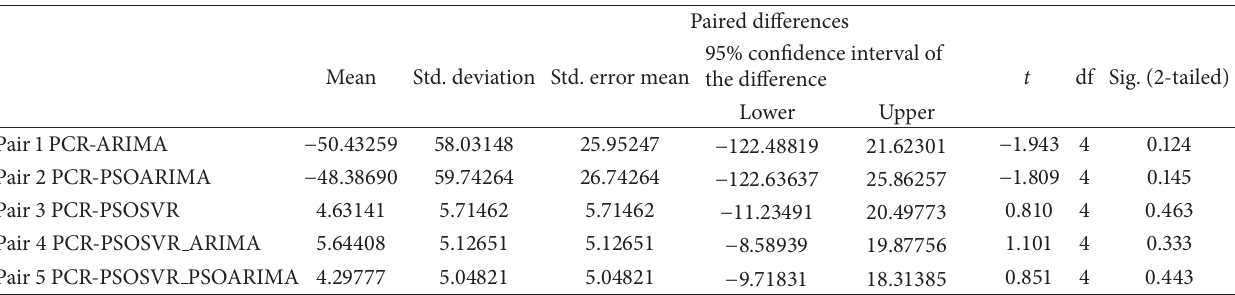
Table 4: Paired samples test. Paired